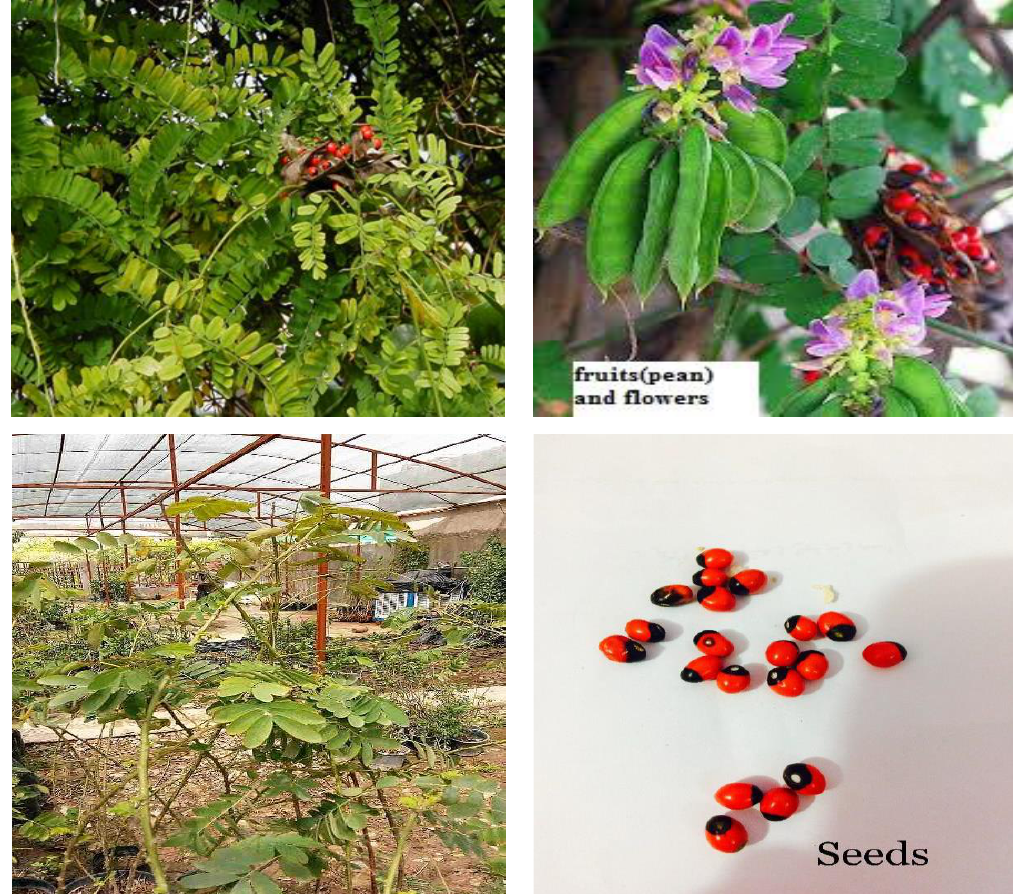
Figure 1. Iraqi Abrus precatorius plant